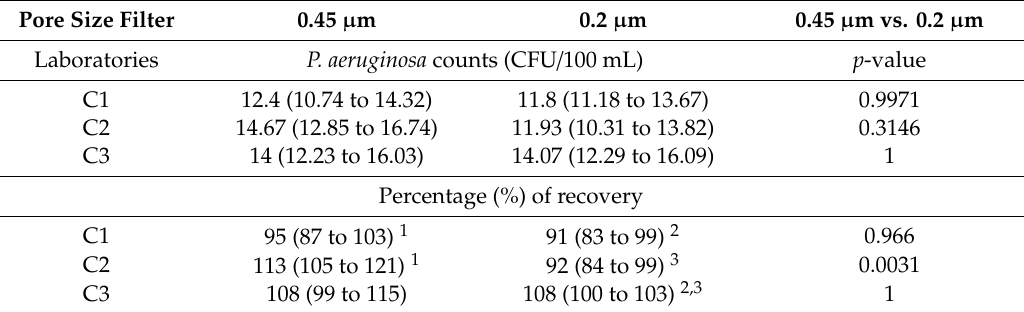
Table 3. Pseudomonas aeruginosa experiment: averages and 95% confidence interval for each laboratory and type of membrane filter. p -values from the generalized model are adjusted according